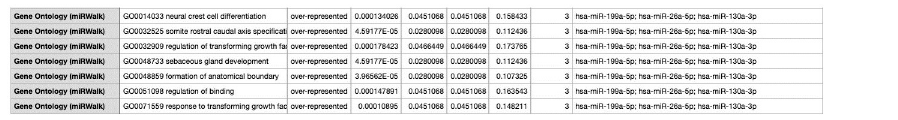
Fig 5. miRWalk GeneOntology database prediction for target